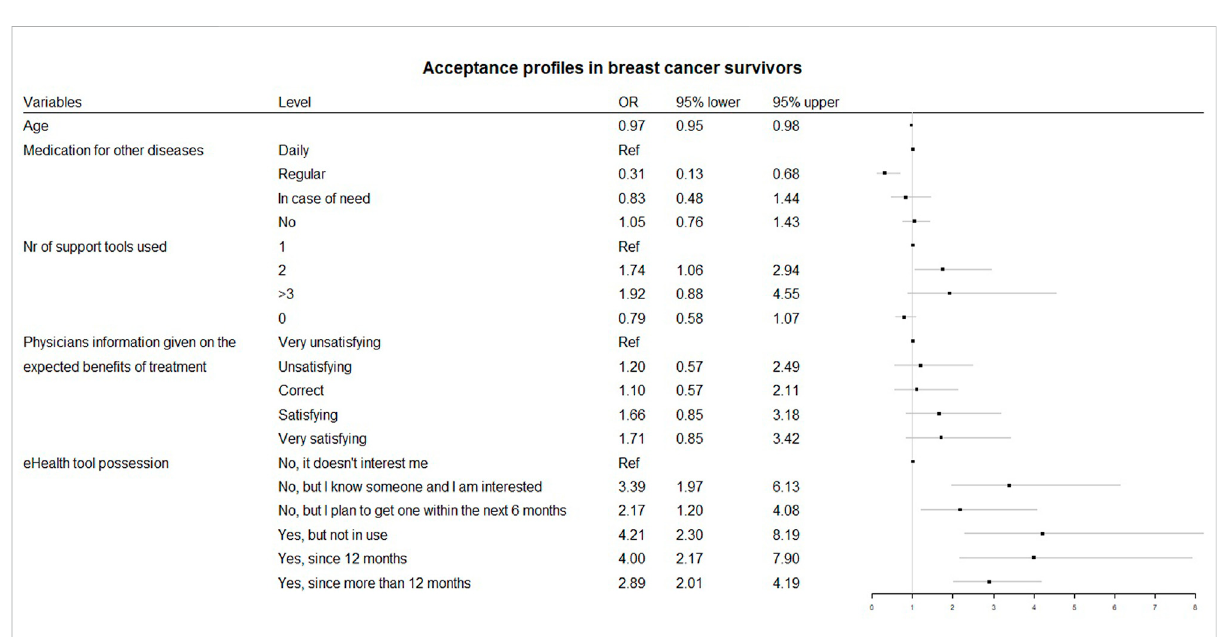
FIGURE 1 Acceptance pro fi les in